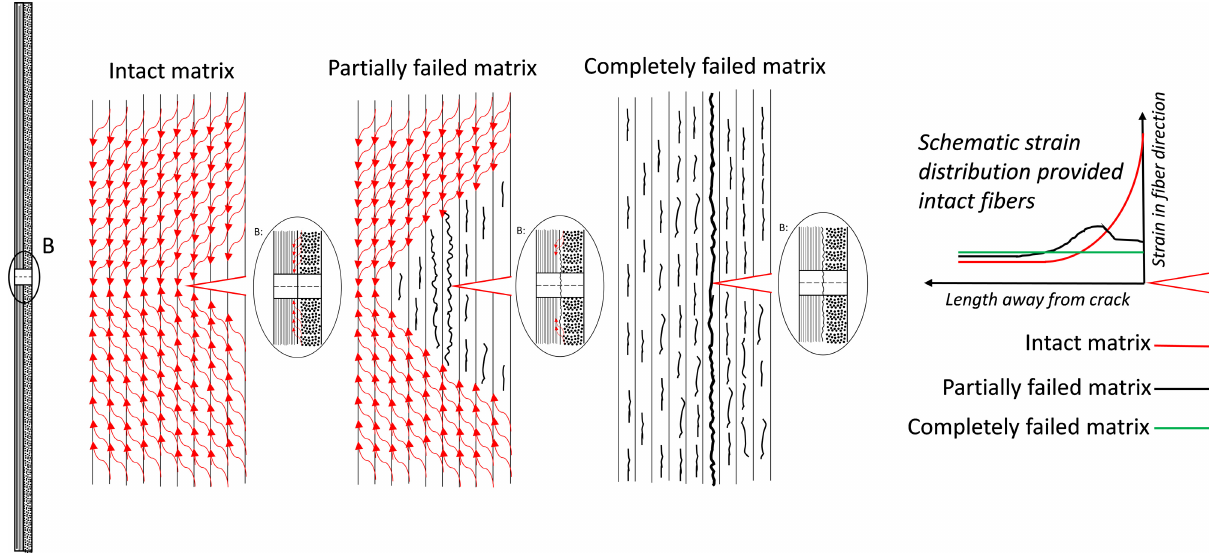
Figure 15: Effect of loss of shear stiffness through matrix damage on the strain distribution around a notch.